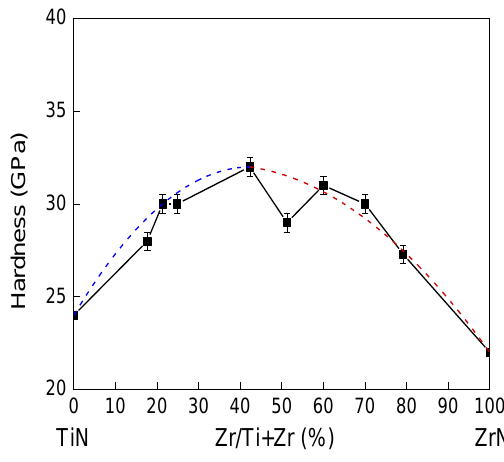
Figure 6. Hardness of the films. The relationship between the composition and hardness of Ti x Zr 1 − x N films has been discussed in other related studies. The hardness of films increases monotonically with increasing Zr/Zr+Ti molar ratios from 6:94 to 18:82 to 35:65 [7]; however, the hardness increases significantly with decreasing Zr/Ti molar ratios from 2.9:1 to 1.8:1 [2]. The hardness of the films also increases monotonically with decreasing Zr/Ti molar ratios